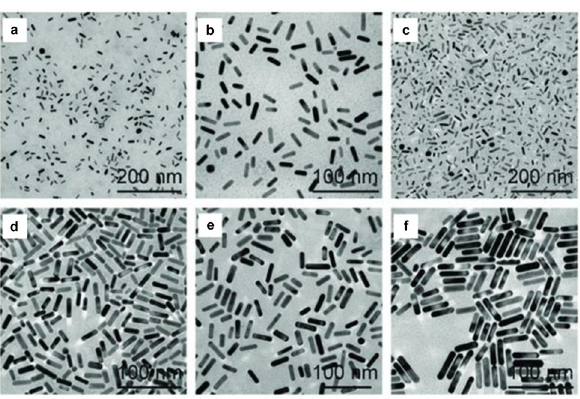
Figure 5: FTIR spectra of ( a ) Fe 3 O 4 , ( b ) PEG ( 1 g ) /Fe 3 O 4 , ( c ) PEG ( 2 g ) / Fe 3 O 4 , ( d ) PEG ( 3 g ) /Fe 3 O 4 , and ( e ) PEG [ 133 ]